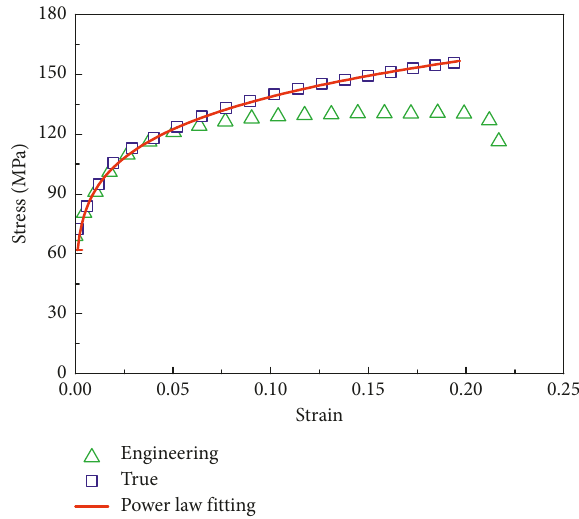
Figure 5: Stress-strain curve of